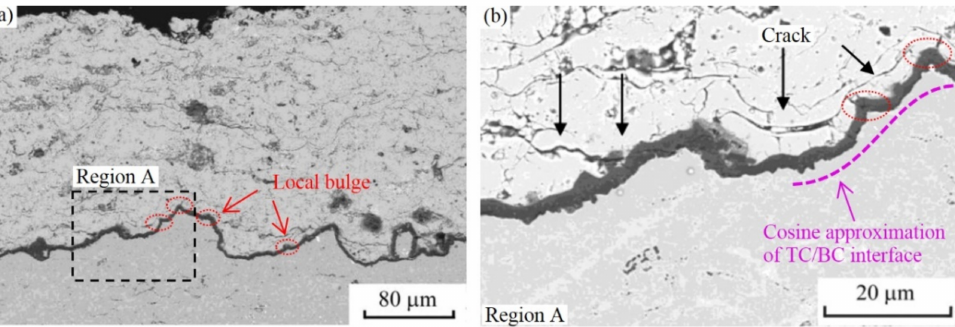
Figure 1. The cross-sectional morphology of APS TBC [50]: ( a ) local bulges at the TC/BC interface and ( b ) a magnification perspective of image in the region